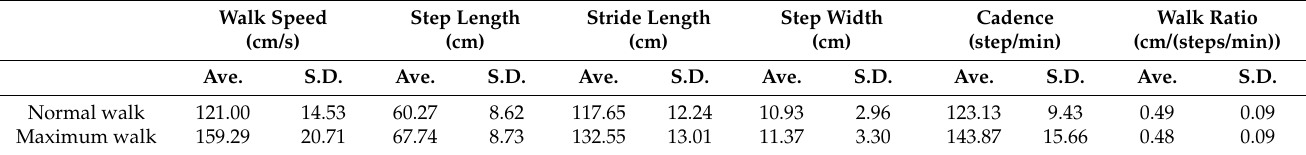
Figure 8. Motion analysis results (example). Table 3. Comparison of gait factors during the normal walking and fast walking of the elderly.